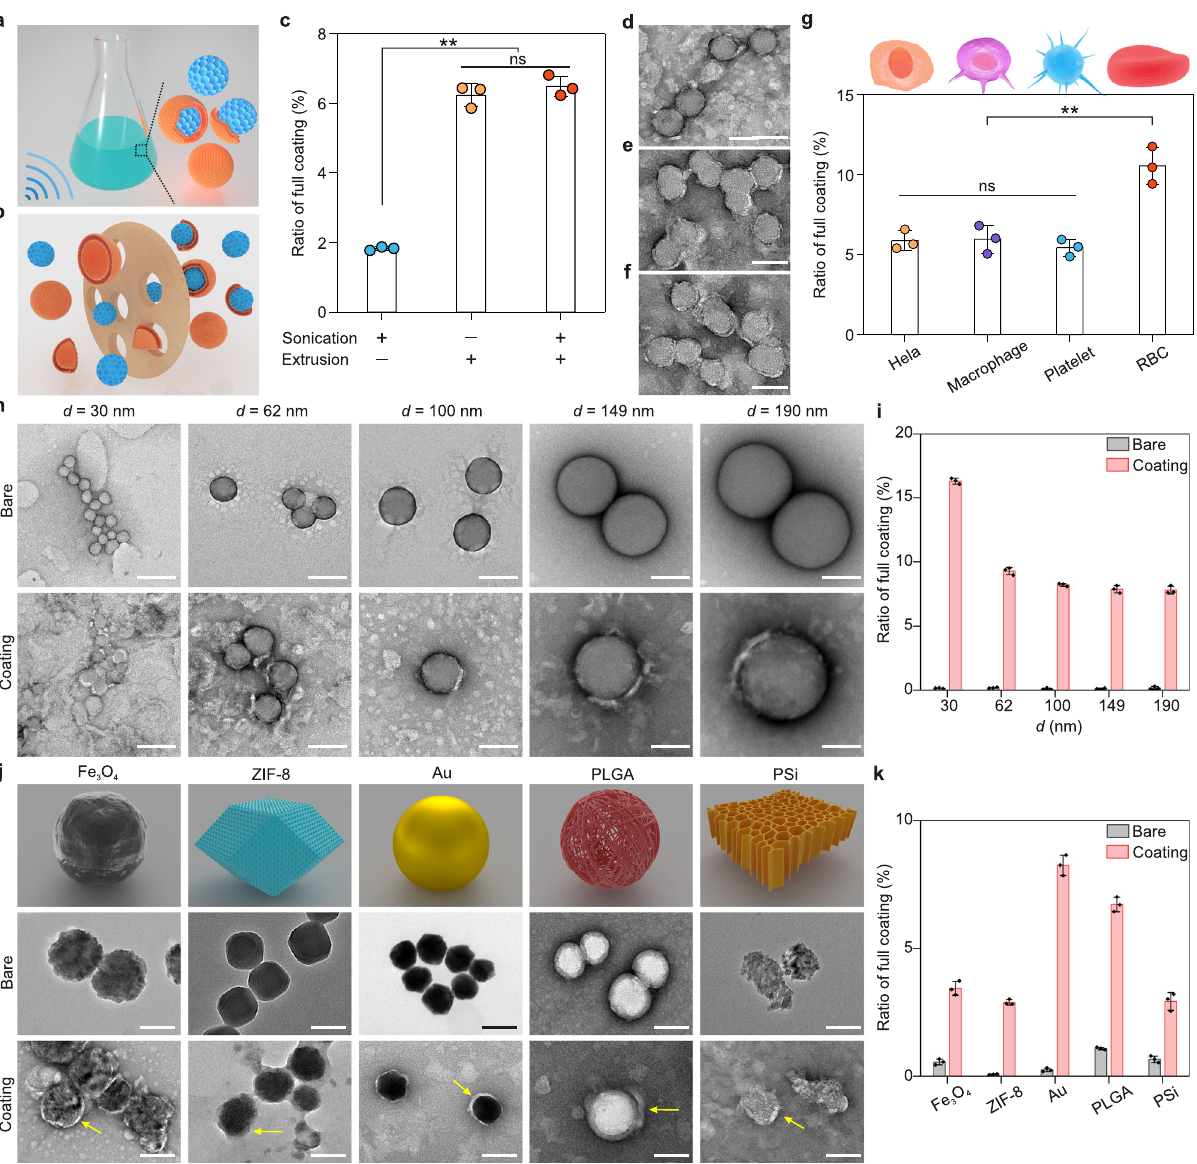
Fig. 2 Validation of partial cell membrane coating under different experimental designs. a , b Schematic illustration of the preparation of cell membrane- coated NPs with a sonication method ( a ) and a physical co-extrusion method ( b ). c Quanti fi cation of the ratio of full cell membrane coating with different coating methods (sonication, extrusion, and combined sonication-extrusion). d − f TEM images of CM-SiO 2 NPs fabricated using sonication ( d ), extrusion ( e ), and combined sonication-extrusion ( f ). Scale bars, 100 nm. g Quanti fi cation of the ratio of full cell membrane coating for SiO 2 NPs coated with different source cell membrane materials (HeLa, macrophage, platelet, and RBC). h TEM images of different sizes of nonporous Stöber SiO 2 NPs before and after coating with cell membranes. Scale bars, 100 nm. i Quanti fi cation of the ratio of full cell membrane coating for cell membrane-coated nonporous Stöber SiO 2 NPs of different sizes. j TEM images of Fe 3 O 4 NPs, ZIF-8 NPs, Au NPs, PLGA NPs, and porous silicon (PSi) NPs before and after coating with cell membranes. Scale bars, 100 nm. k Quanti fi cation of the ratio of full cell membrane coating for different core materials (Fe 3 O 4 NPs, ZIF-8 NPs, Au NPs, PLGA NPs, and PSi NPs). Data represents mean ± SD ( n = 3). One-way ANOVA followed by post hoc Tukey test was used to determine the signi fi cance in c and g . p = 1.7E-6 ( c : sonication + and extrusion – vs. sonication – and extrusion + ), p = 1.2E-6 ( c : sonication + and extrusion – vs. sonication + and extrusion + ), p = 6.1E-4 ( g : RBC vs. Hela), p = 7.0E-4 ( g : RBC vs. macrophage), p = 3.3E-4 ( g : RBC vs. platelet). ** p < 0.01. ns: not signi fi